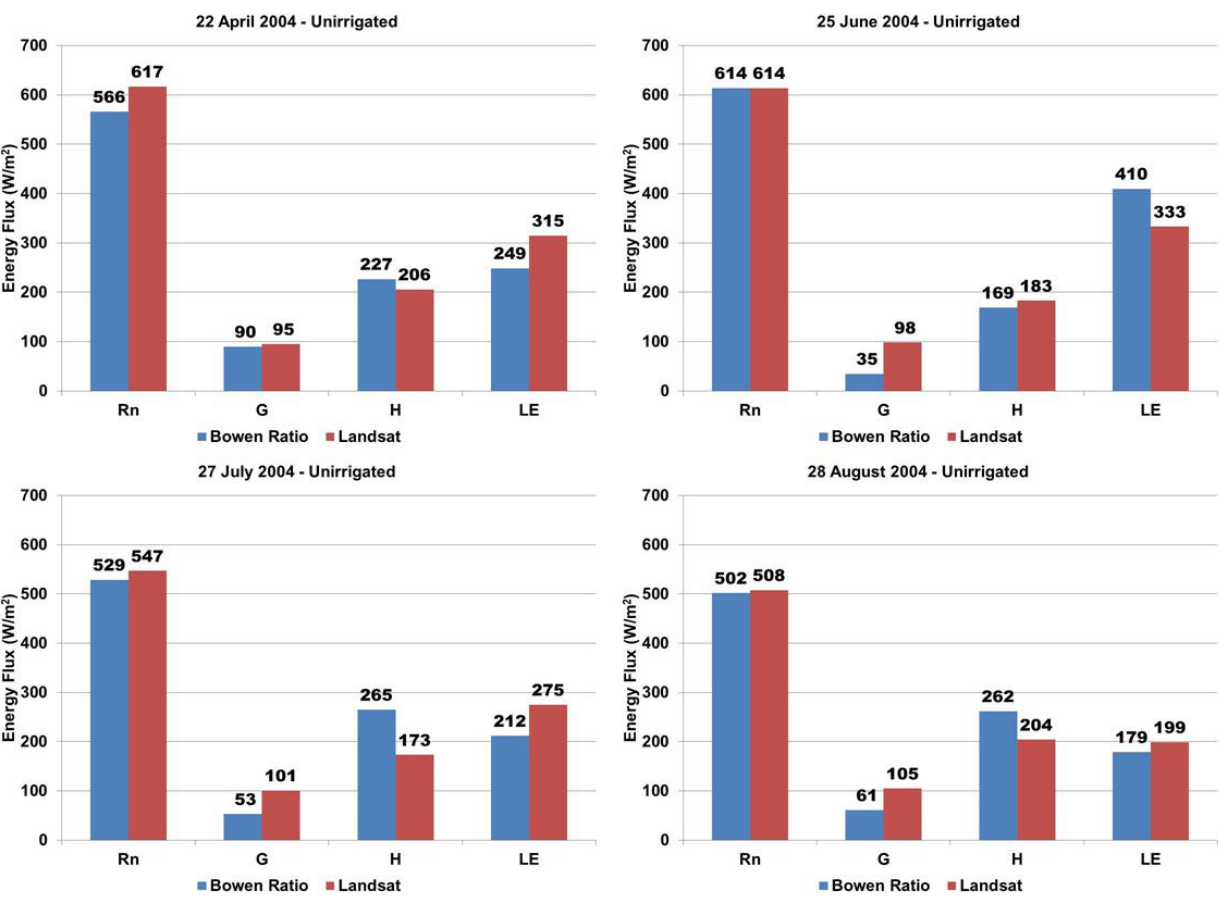
Figure 8. Results of reconstructed ET algorithm calculation for components of the energy balance from four Landsat scenes for the unirrigated site